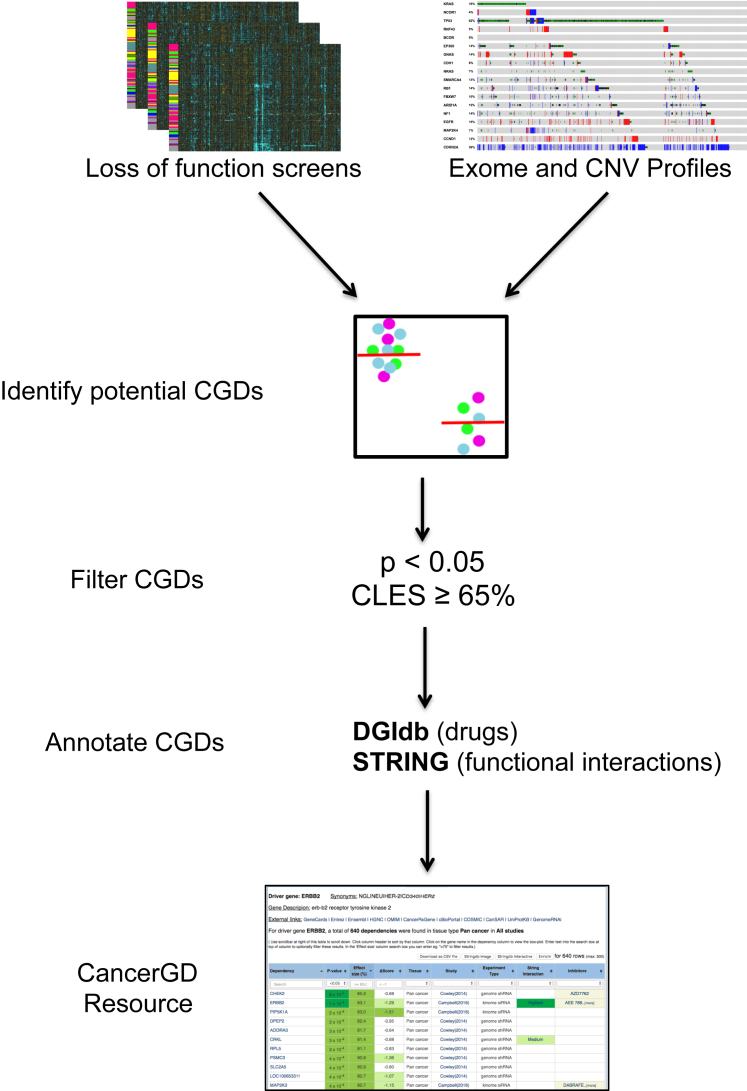
CancerGD OverviewLoss-of-function screens from multiple sources are integrated with exome and copy-number profiles from the GDSC resource. Cell lines are annotated according to the mutational status of a panel of driver genes (see Table S1). Statistical analysis is then performed to identify associations between the presence of driver gene alterations and sensitivity to reagents targeting specific genes. These CGDs are filtered such that only those with nominal significance (p < 0.05) and moderate common language effect sizes (≥65%) are retained. Finally, all CGDs are annotated according to whether they occur between driver-target pairs with known functional relationships (STRING) and whether there is an inhibitor available for the target gene (DGIdb).